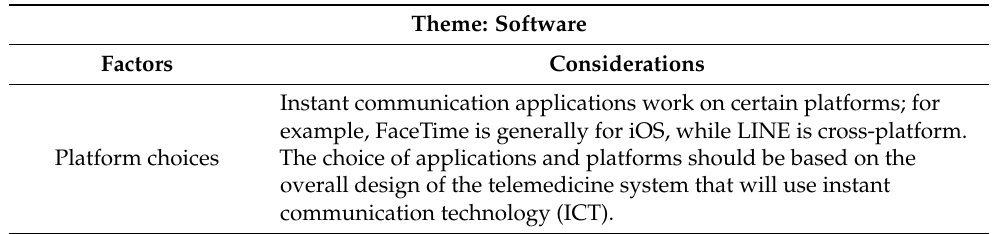
Table 3. Important considerations regarding the software when using instant communication tech- nology for patient assessment in an emergency